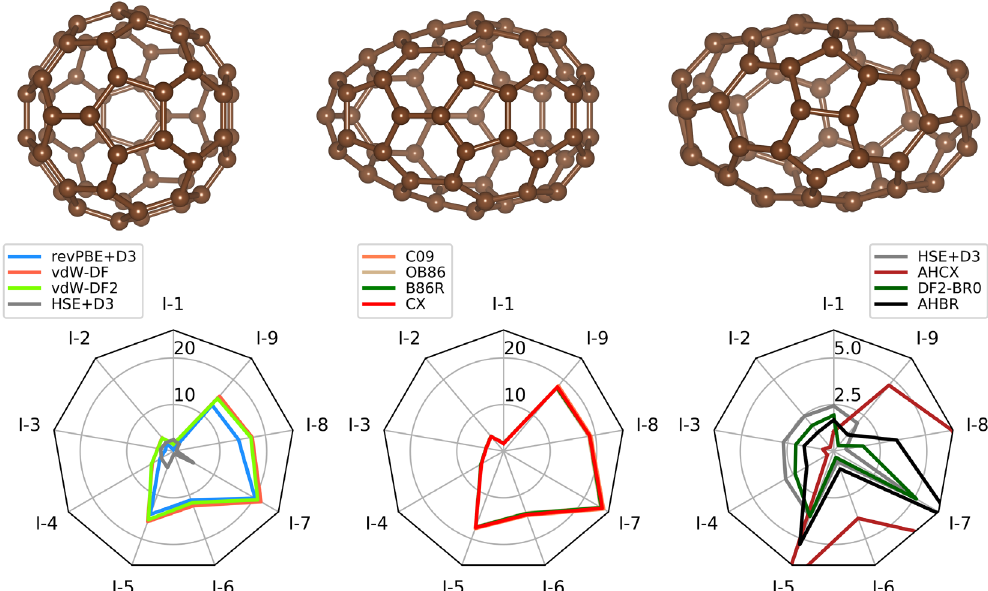
FIG. 6. Performance of original vdW-DF releases (left panel), recent regular vdW-DFs (middle panel), and hybrid vdW-DFs (right panel) on a set of C 60 isomerization problems. The top left (right) panel shows the regular (highly distorted) configuration. The middle panel depicts one of the intermediate configurations in the transformation, as tracked in the C60ISO benchmark set [69]. The bottom left (middle) panel shows MAD values (in kcal/mol) characterizing the performance of the original vdW-DF releases (recent regular vdW- DFs) on describing energy differences between such configurations. The bottom right panel shows that the hybrid vdW-DFs are needed to substantially improve the